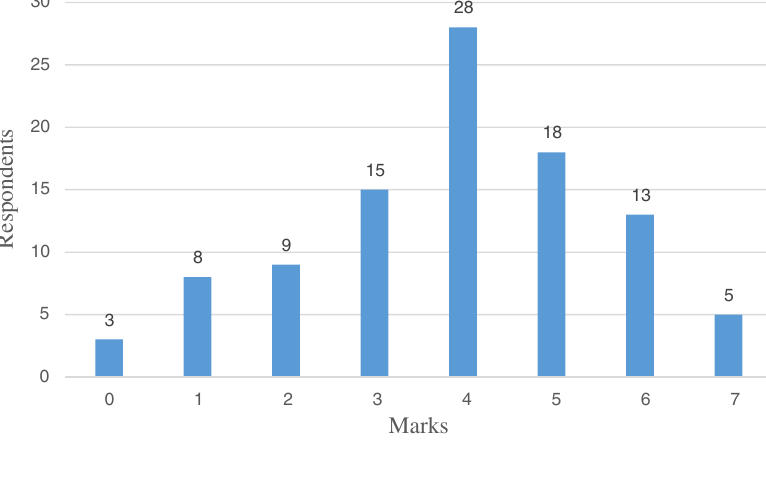
Fig. 1 Distribution of marks scored by respondents ( n =